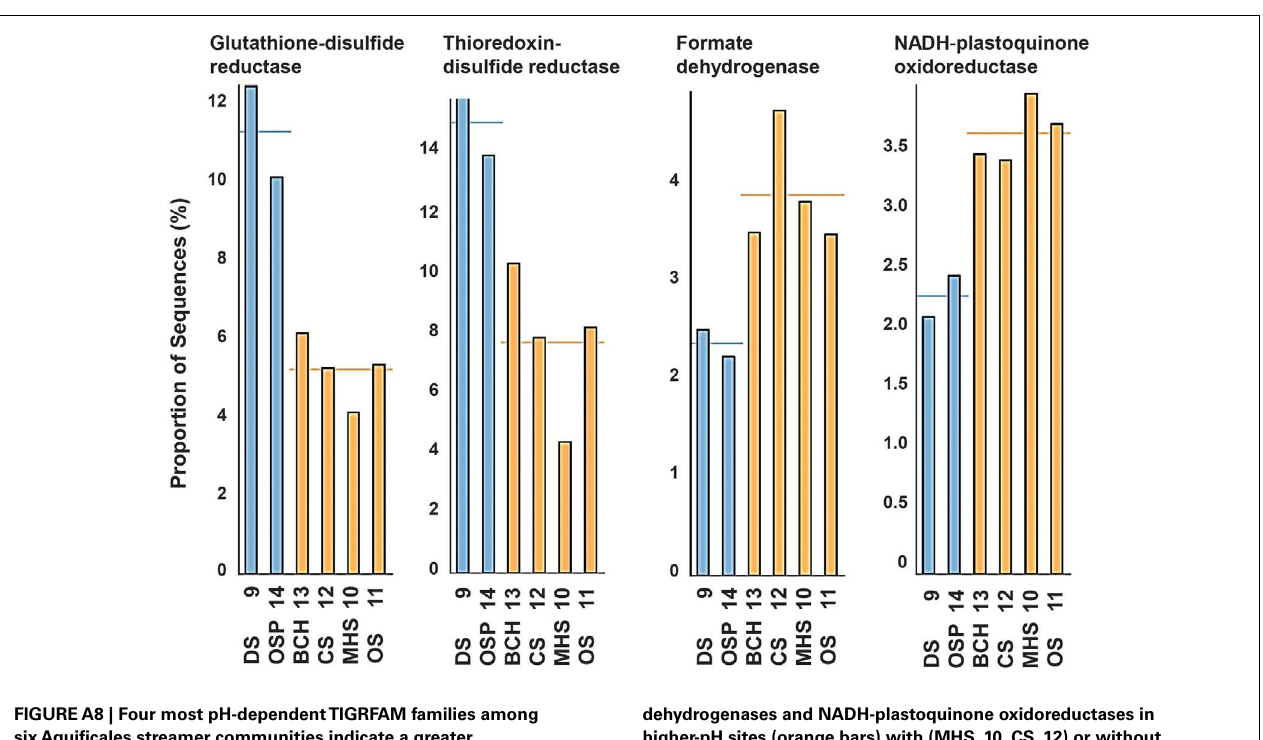
FIGUREA8 | Four most pH-dependentTIGRFAM families among sixAquificales streamer communities indicate a greater proportion of glutathione disulfide and thioredoxin-disulfide reductases in low-pH sites (blue bars) (sulfide present in both DS_9 and OSP_14) and a greater representation of formate